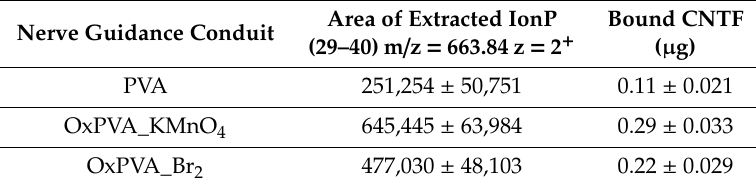
Table 1. CNTF binding. Estimated amount of CNTF bound in the luminal surface of PVA- and oxidized PVA-based nerve guides.